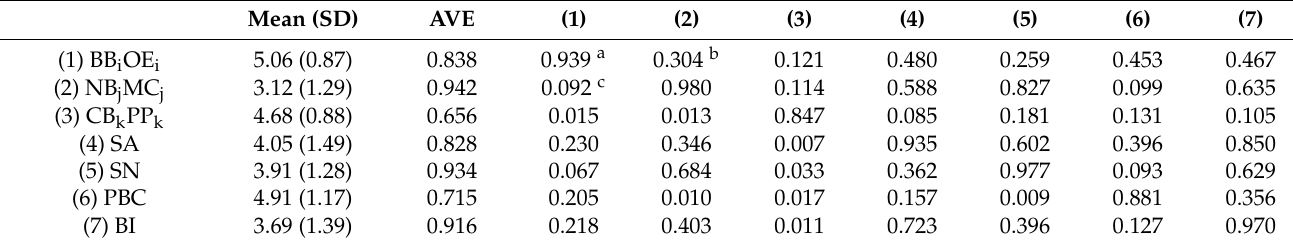
Table 2. Descriptive statistics and associated measures.